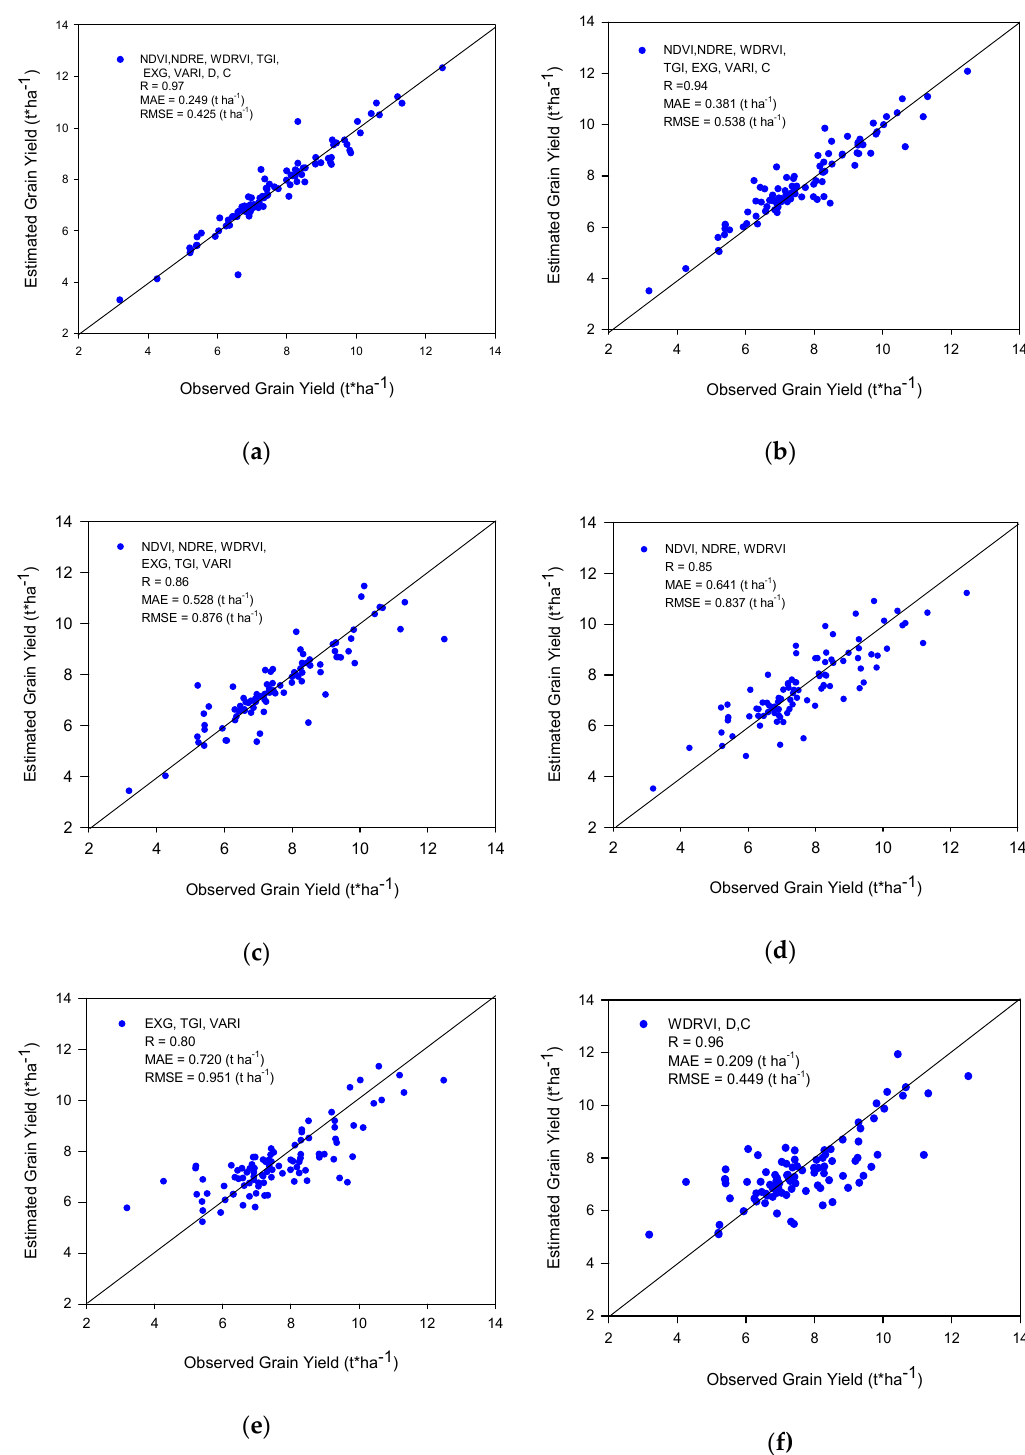
Figure 8. Yields estimated by the neural network during 79 DAS for all observed yield data. ( a ) Yield estimated with the NDVI, NDRE, WDRVI, EXG, TGI, and VARI vegetation indices, as well as plant density (D) and canopy cover (C); ( b ) yield estimated with the NDVI, NDRE, WDRVI, EXG, TGI, and VARI vegetation indices, as well as C; ( c ) yield estimated with the NDVI, NDRE, WDRVI, EXG, TGI, and VARI vegetation indices; ( d ) yield estimated with the NDVI, NDRE, and WDRVI vegetation indices; ( e ) yield estimated with EXG, TGI, and VARI vegetation indices; ( f ) yield estimated with the WDRVI vegetation index, as well as D and C.